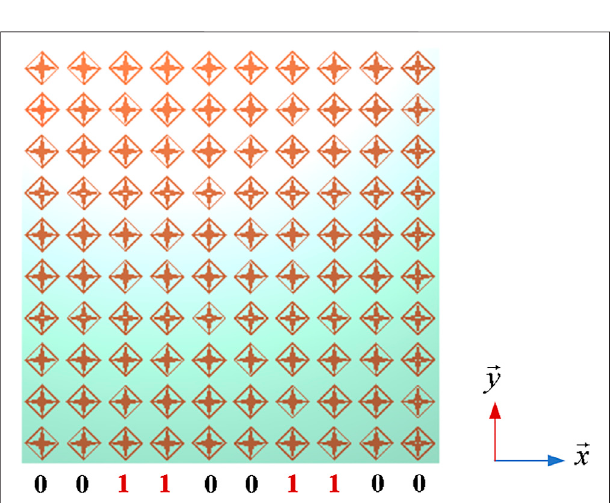
TABLE 1 | Comparison with recently reported relevant works.